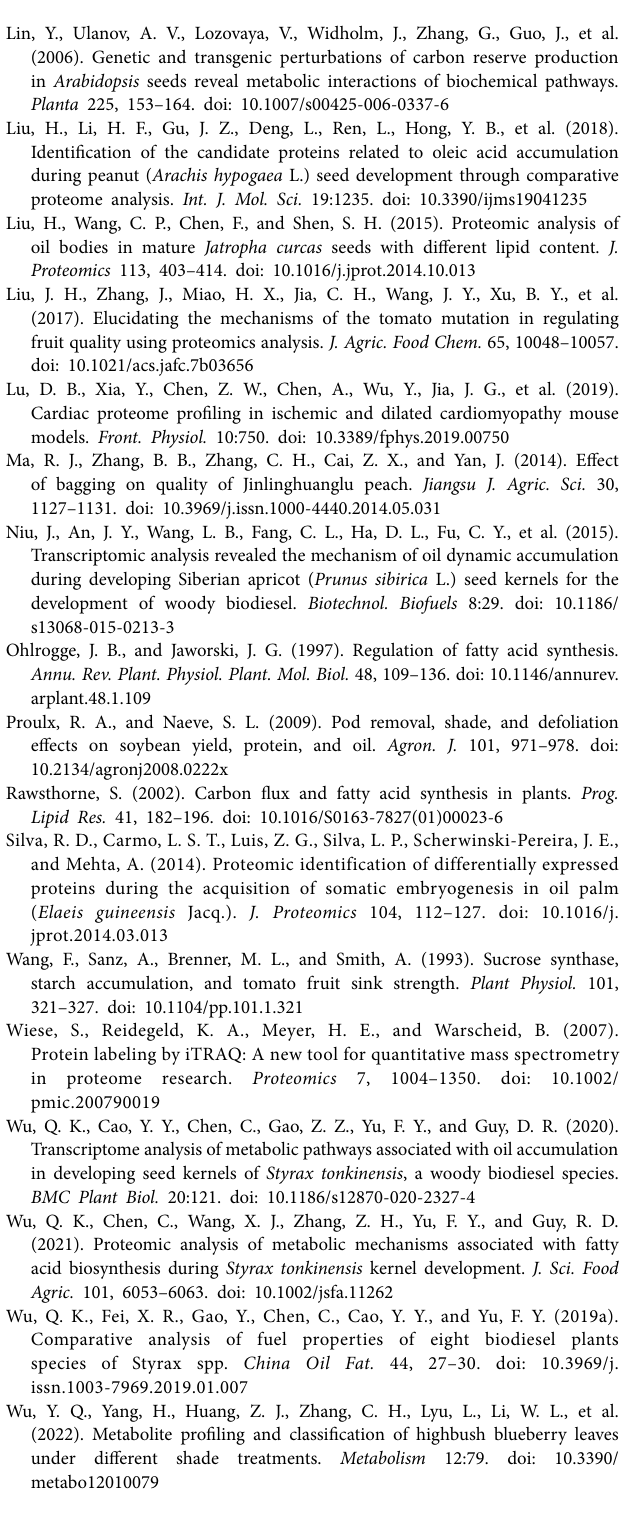
Supplementary Table 1 | Primer sequences used in the experiments. Supplementary Table 2 | Proteins identified during S. tonkinensis kernel development.